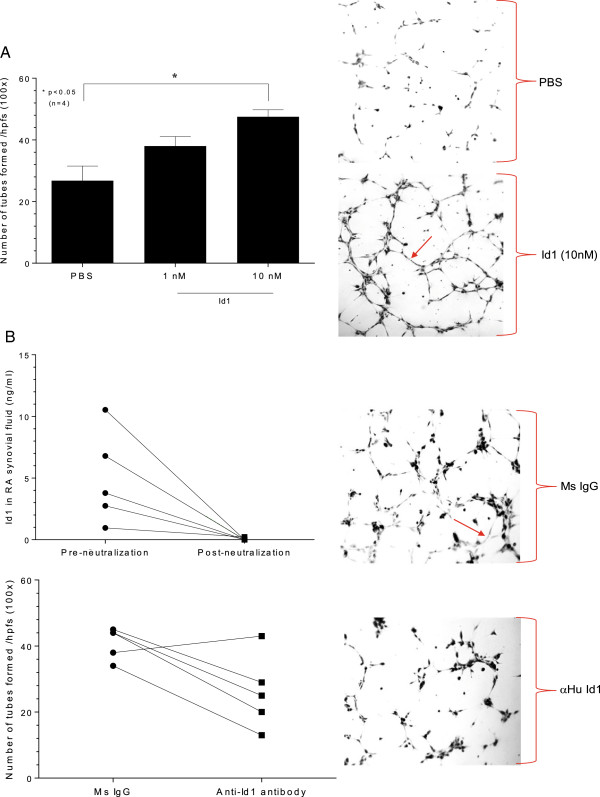
In vitro Matrigel tube formation assay. A) Matrigel tube formation assay using growth factor-reduced Matrigel (BD Biosciences) was performed. The test substances used were recombinant human Id1 (rhuId1) (1 and 10 nM), basic fibroblast growth factor (bFGF) (60 nM, R&D Systems, positive control) and phosphate-buffered saline (PBS) (negative control). The treated human dermal microvascular endothelial cells (HMVECs) (1.8 × 104 cells/400 μl) were plated on Matrigel in the presence of Id1, bFGF or PBS for six hours at 37°C. Photographs (100×) were taken and tubes were counted by a blinded observer. Tubes were defined as elongated connecting branches between two identifiable HMVECs. A) HMVECs formed tubes to Id1 at 10 nM (the concentration for peak HMVEC chemotactic activity for HMVECs, n = number of independent experimental replicates). B) Rheumatoid arthritis (RA) synovial fluid (SF) was pre-incubated with mouse anti-human Id1 antibody (Abcam) for two hours at 4°C. RA SFs were added in the Protein A agarose beads and were rotated at 4°C overnight. The next day, the samples were spun down and SFs collected. SFs were diluted 1:100 with PBS. We then measured Id1 in the SFs pre- and post-Id1 neutralization, and as shown, effectively eliminated Id1 from the SFs. RA SF depleted of Id1 showed less HMVEC tube forming activity compared to “sham”, IgG depleted SFs. Photographs (100×) were taken and tubes were counted by a blinded observer (n = number of independent experimental replicates).